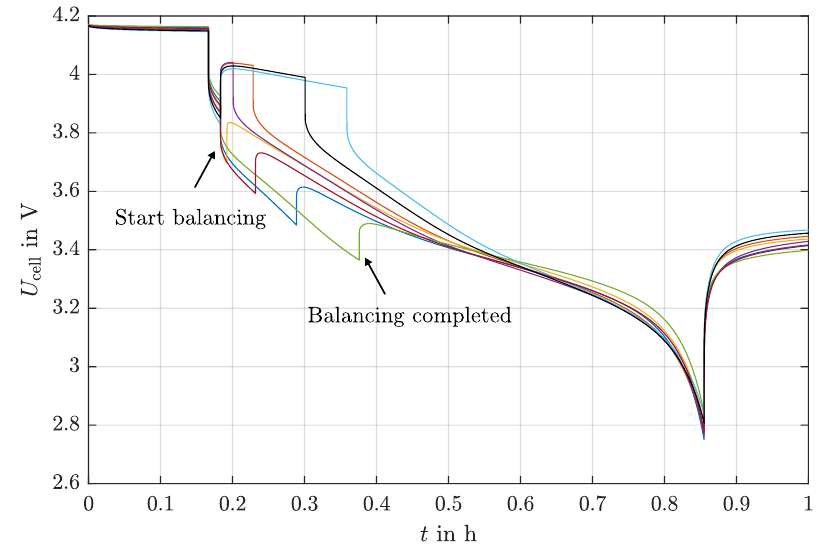
Figure 8. Voltage curves of the 8 cells during discharge with active